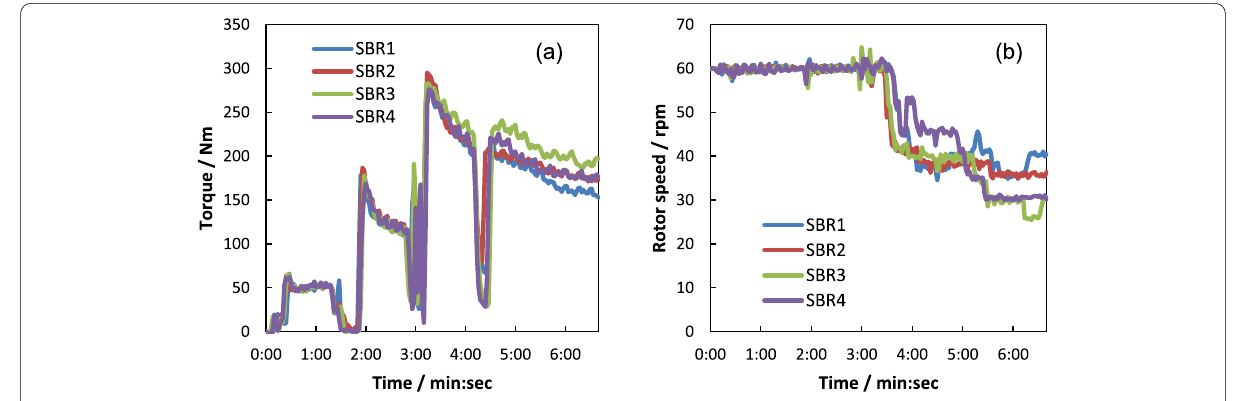
Fig. 8 Mixing behavior of the compounds with linear SBRs; a mixing torque, b rotor speed